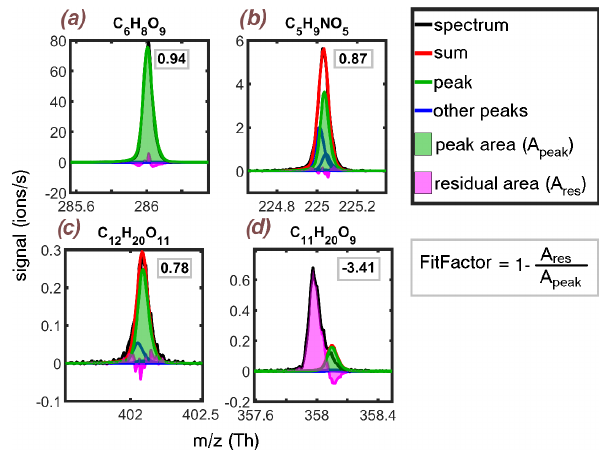
Figure A1. Examples of determining the FitFactor from the residual-to-peak ratio of four different compounds. The title com- pounds are indicated by green lines and shading. The FitFactor value for each is shown in the upper right corner of the subplots. (a) A good fit results in a FitFactor close to 1. (b) Accurate determi- nation of the fit quality is tricky when this many compounds and/or isotopes are fitted to the same spectral peak. Automatic fitting can artificially produce a good sum fit, which translates into a good Fit- Factor, but single compound fits may lack credibility. (c) The two fitted peaks match the spectra relatively well, resulting in a reason- ably good FitFactor for the bigger peak. (d) A very poor fit results in low or even negative